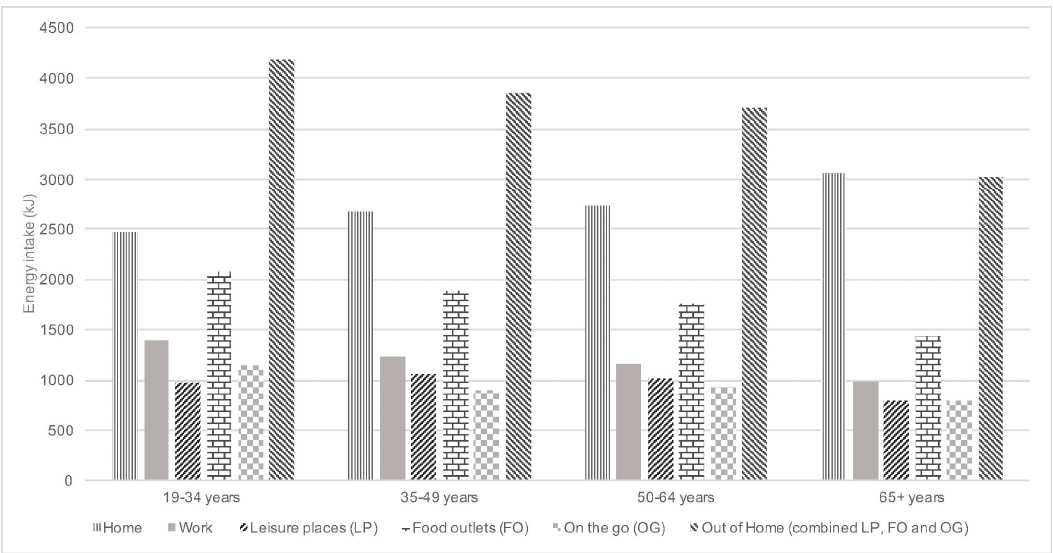
Figure 3. Energy intake (kJ) by reported eating location for the NDNS RP Years 1–6 (2008–2014) adult population.